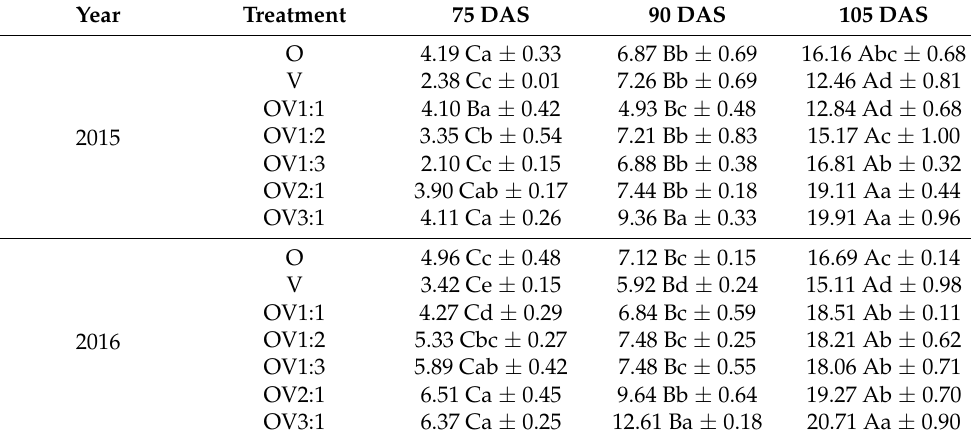
Table 5. The effect of different intercropping ratios of oat and common vetch on dry matter biomass (t · hm − 2